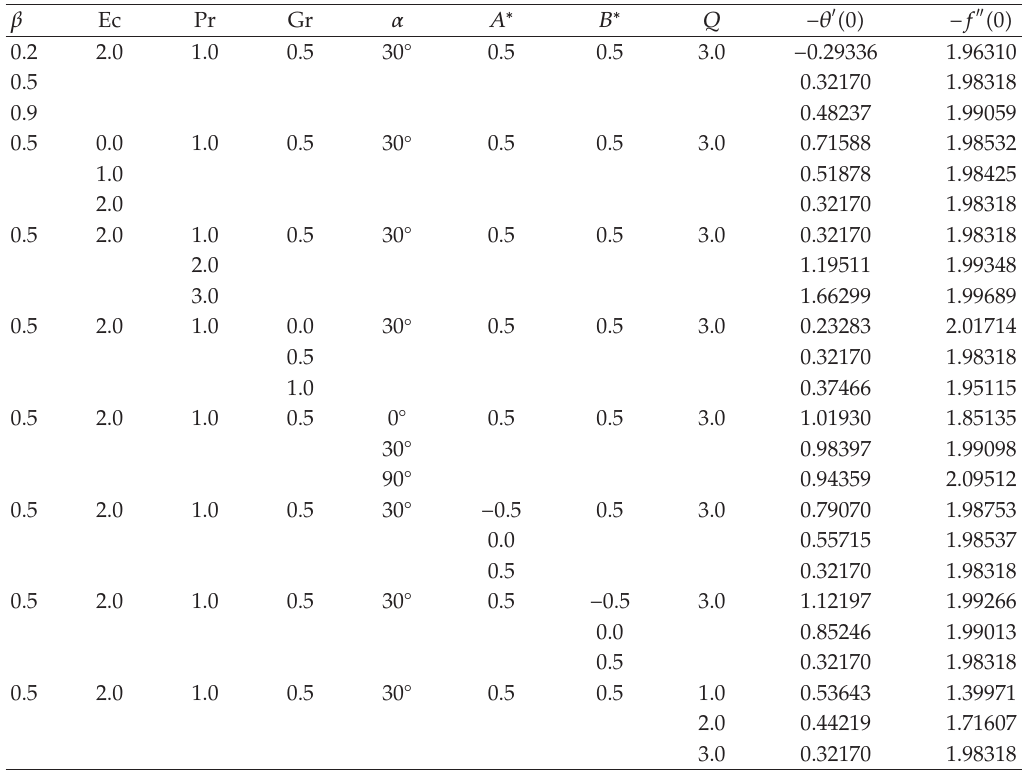
Table 3: Values of wall velocity gradient − f (cid:5)(cid:5) (cid:5) 0 (cid:6) temperature gradient − θ (cid:5) (cid:5) 0 (cid:6) for di ff erent values of β , α , Q , Gr, A ∗ , B ∗ , Pr , and